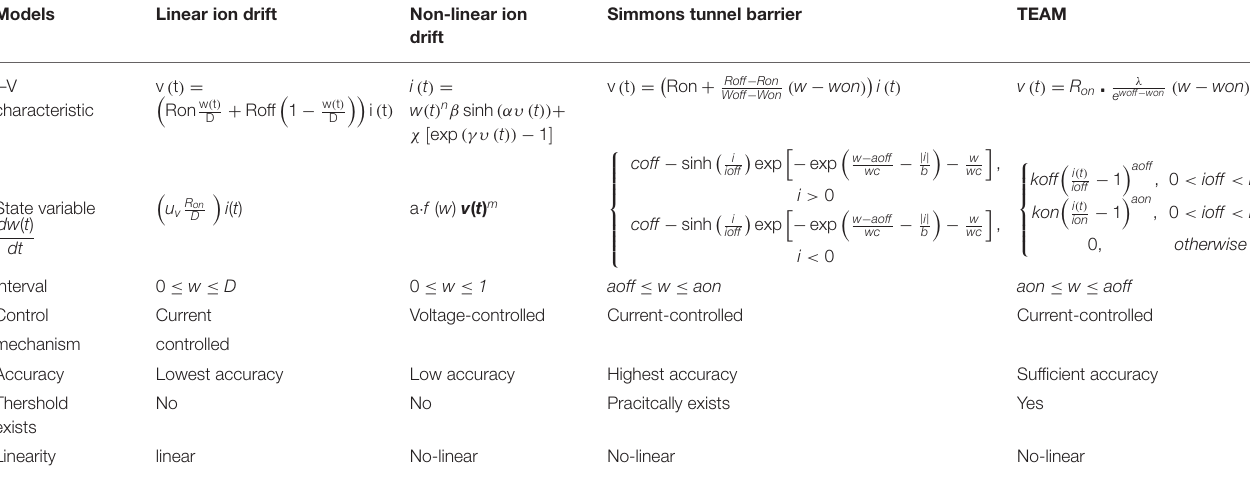
TABLE 1 | Classic memristor models.